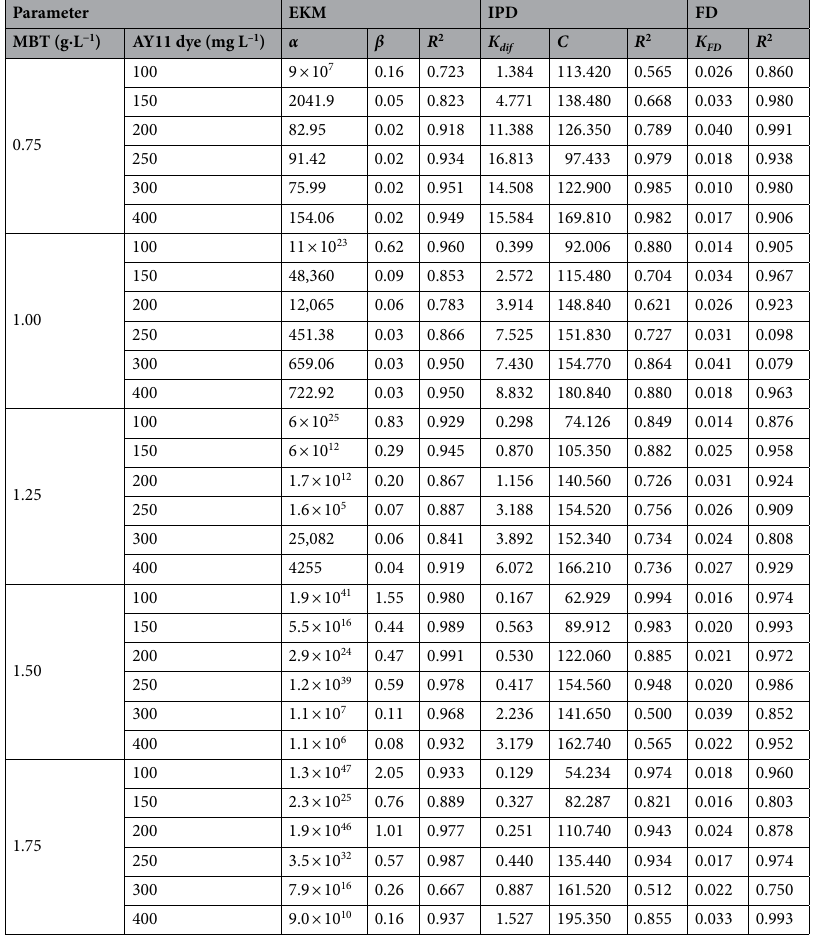
Table 4. Results of removal of AY11 dye by MBT using EKM, IPD, and FD model parameters.